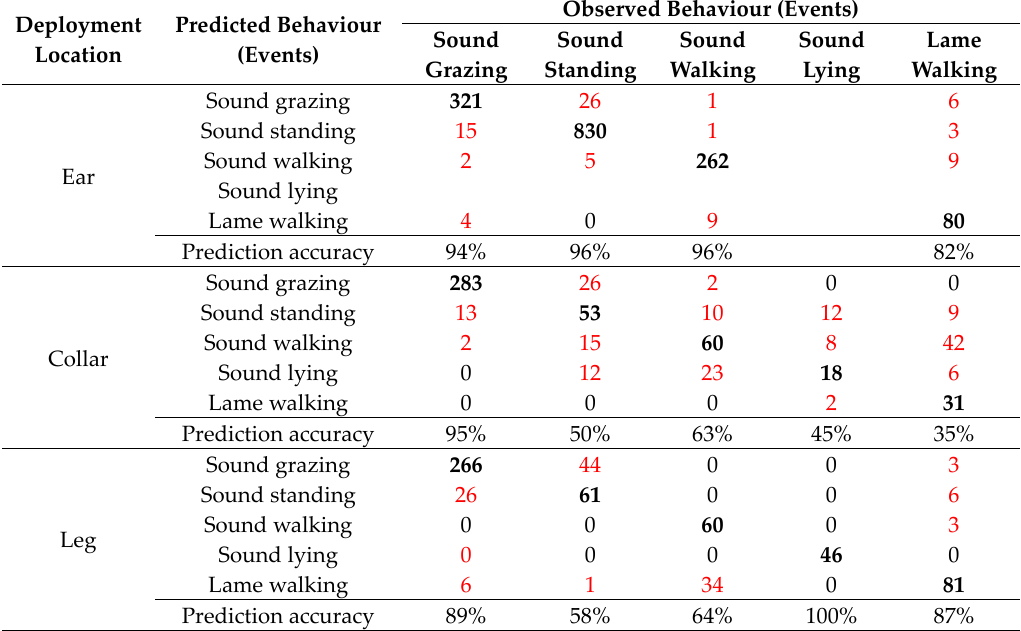
Table 6. QDA confusion matrices of the leave-one-out cross validation analysis for the classification of five mutually exclusive behaviours (Analysis II) using accelerometers deployed in three locations (collar, leg, and ear). The QDA algorithm used the top three ranked metrics from the respective data sets for the discrimination of behaviour. Correctly predicted events are shown in bold and misclassifications in red.